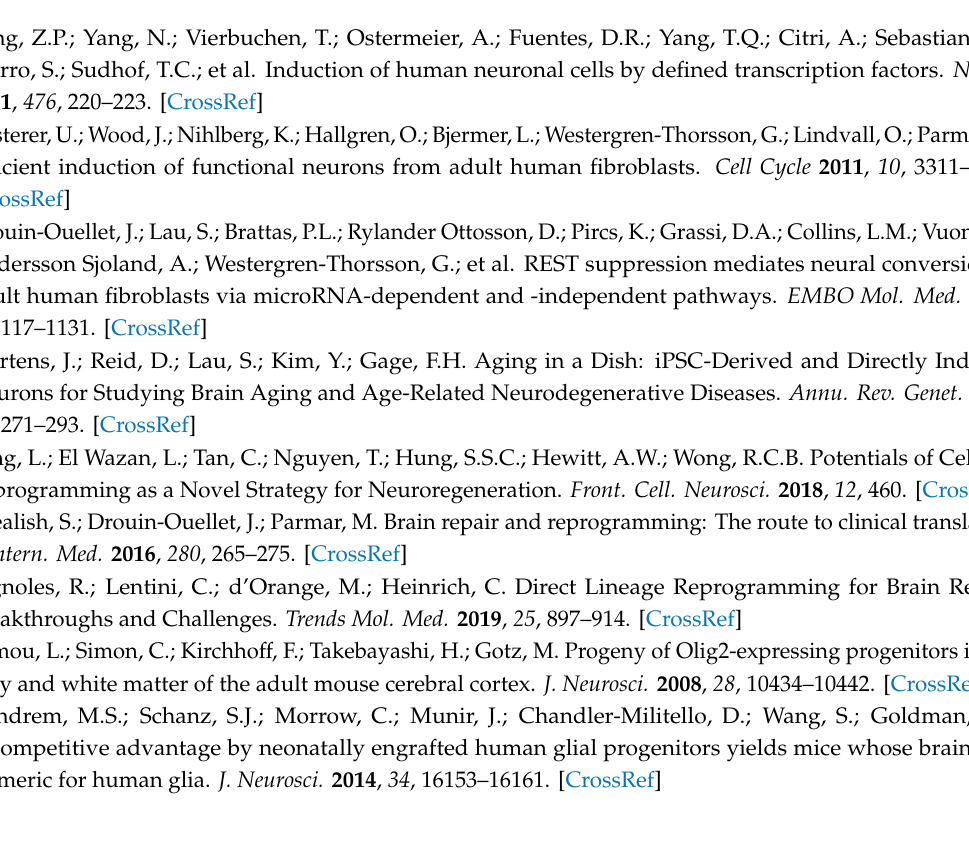
Table S1: Primers used for RT-qPCR analysis, Table S2: List of primary antibodies used in this study, Table S3: List of cell batches used as starting cells for reprogramming experiments, Figure S1: Immunocytochemistry of GABA and glial markers in control groups after 26 days in culture, Figure S2: Inward Na + and outward K + currents blocked by TTX + TEA at 8